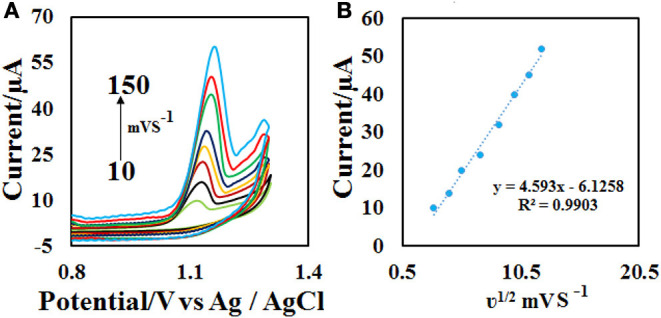
(A) CVs on the CdO/Fe3O4/CPE in 0.1 M phosphate buffer (pH = 4.0) containing 50 μM ACV solution at different scan rates (10–150 mVs−1) and (B) the plot of (B)
Ip vs. υ1/2.